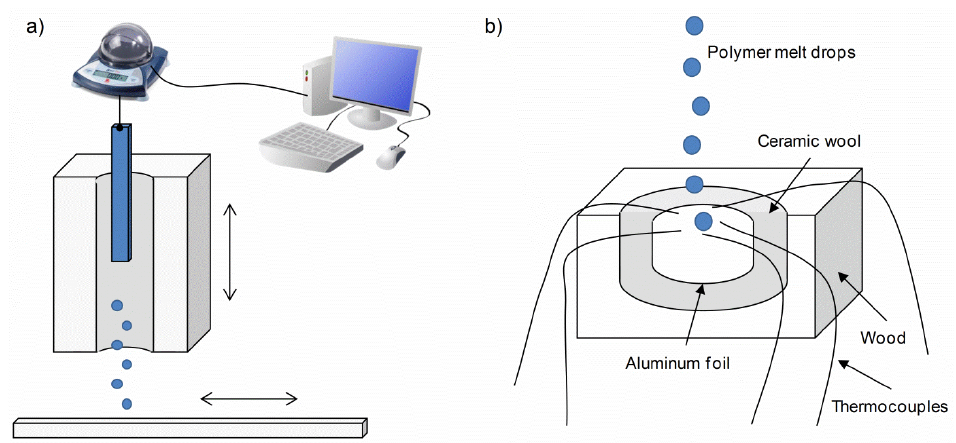
Figure 13. Scheme of the experimental setup for: ( a ) mass loss measurement; and ( b ) temperature measurement.